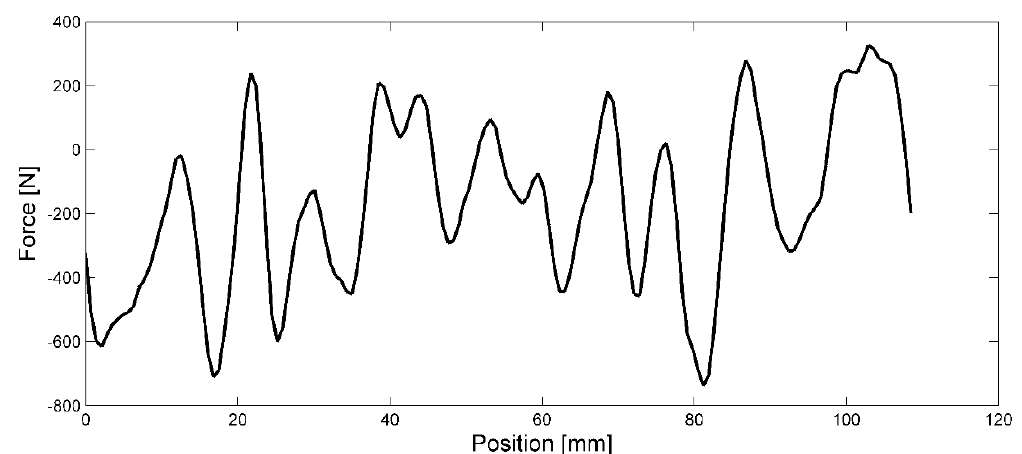
Figure 10. The graph presents the cogging force result when the longitudinal end effects are neglected during one electric period.